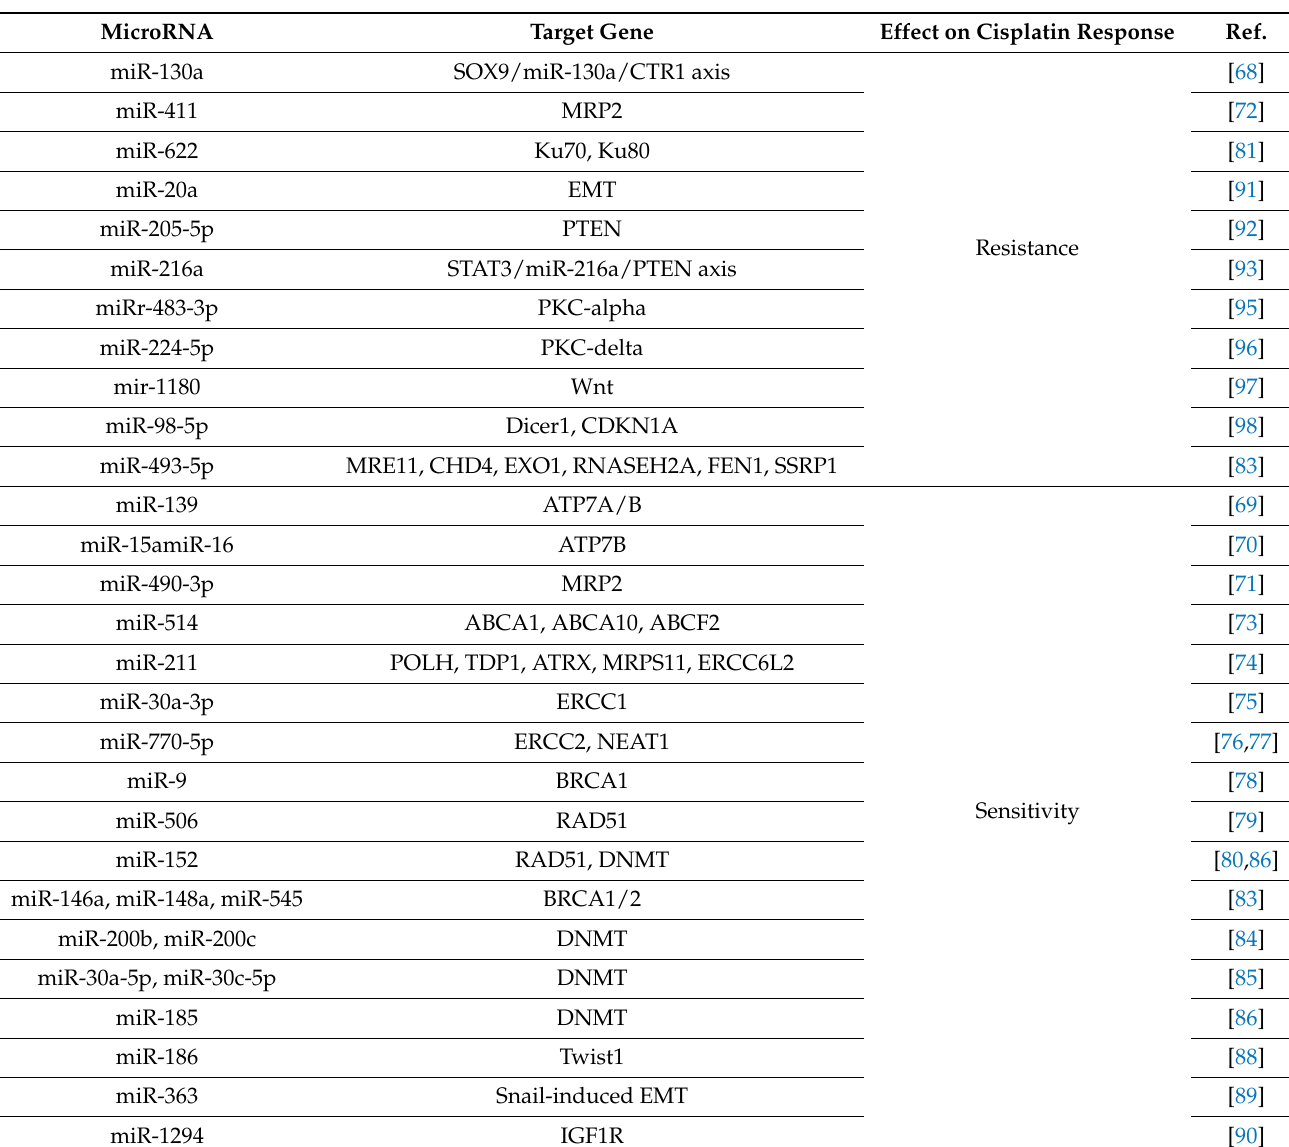
Table 1. MicroRNA involvement in HGSOC platinum